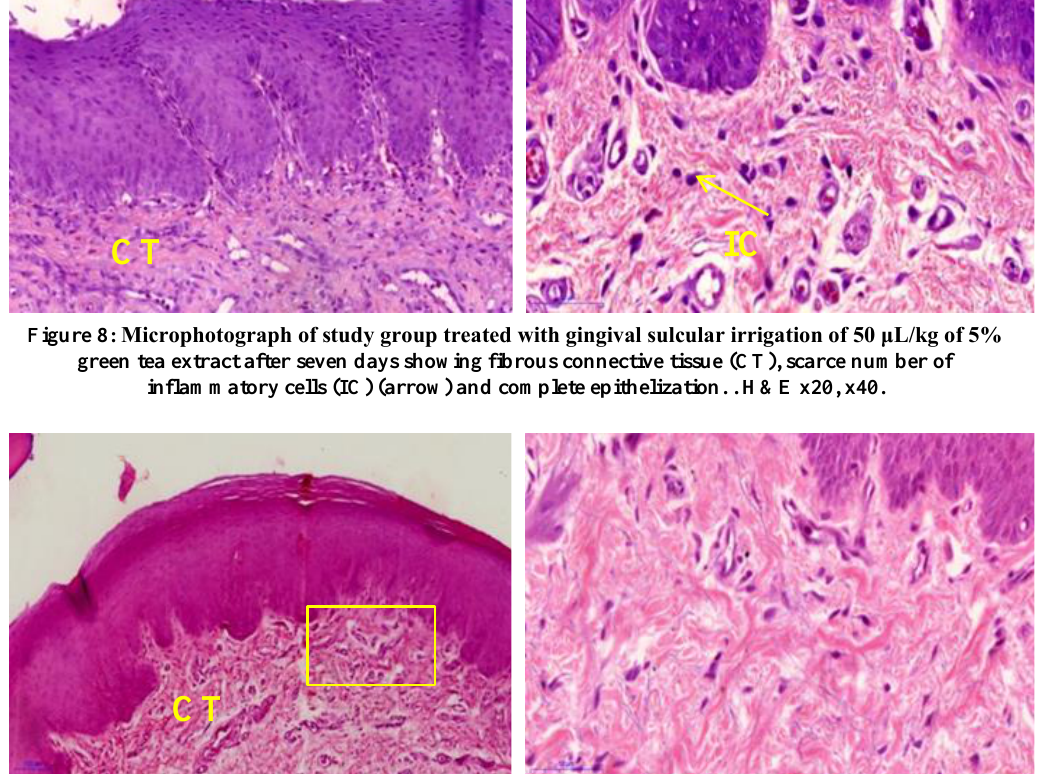
Figure 9: Microphotograph of study group treated with gingival sulcular irrigation of 50 μL/kg of 5% green tea extract after 14 days showing complete epithelization, dense fibrous connective tissue (CT). H&E x20, x40. 1 shows descriptive statistics of inflammatory cell count/ mm 2 of control and study groups at different healing periods (1, 3, 7 and 14 days) at the gingival inflammatory